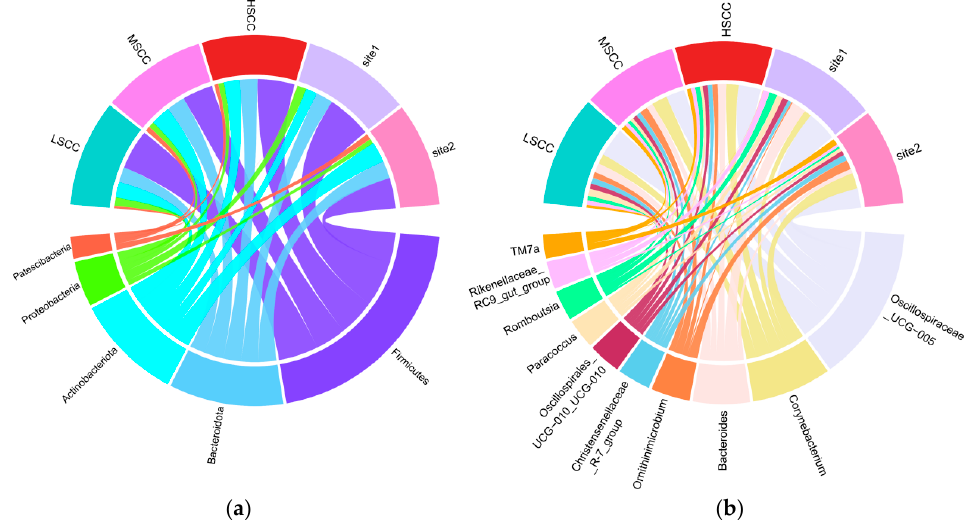
Figure 1. Microbiota composition at the phylum and genus level. ( a ): Top 5 most dominant phyla identified based on the mean relative abundance of all samples. ( b ): Top 10 most dominant genera identified based on the mean relative abundance of all samples.